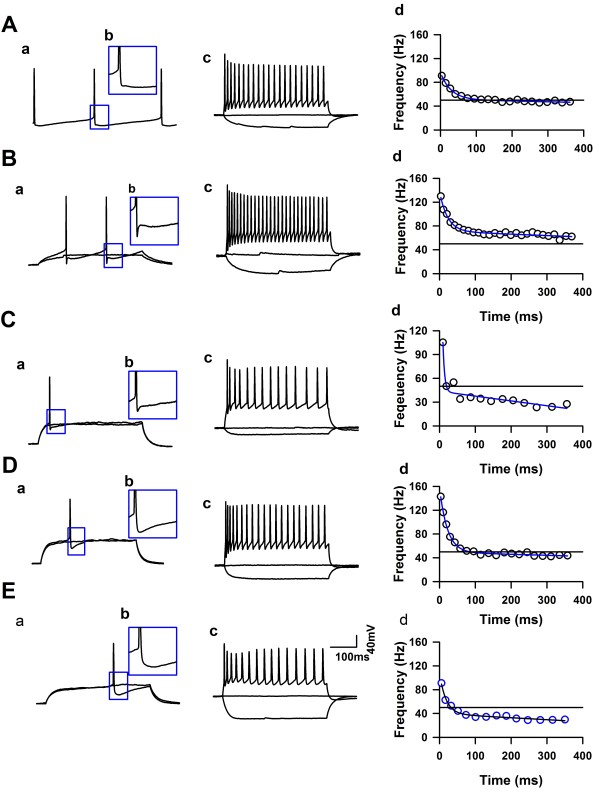
The firing characteristics of spontaneous firing neurons. A &B), The representative traces showed the spontaneous firing of APs from two neurons, respectively. C &D), The distributions of firing frequency collected from the represented neuron in Panel A and B, respectively. E), Distributions of the mean value and S.D. of firing frequency. F), The mean value of firing frequency negatively correlated with membrane time constant.